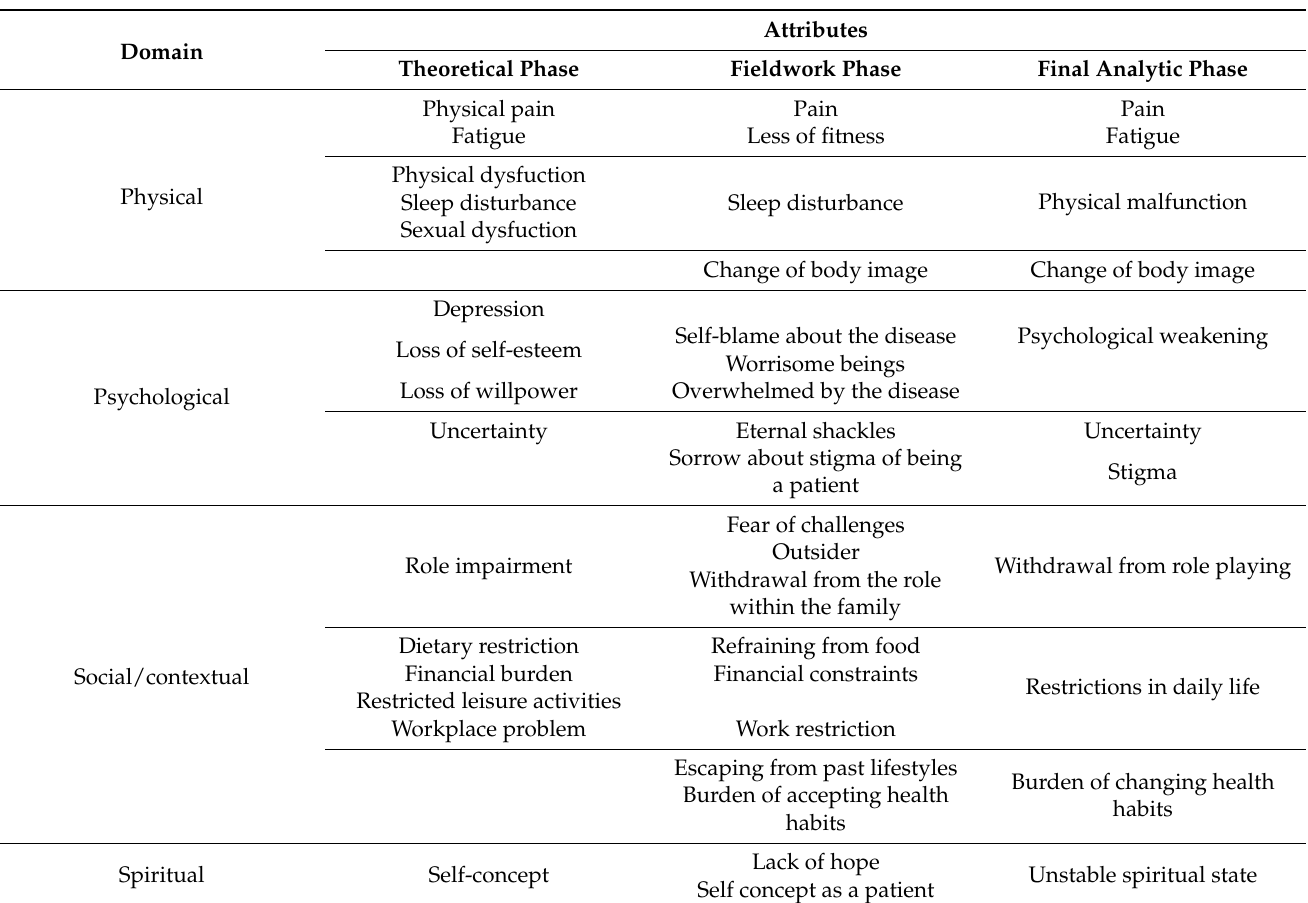
Table 4. Attributes of illness intrusiveness of chronic disease according to three phases by Hybrid